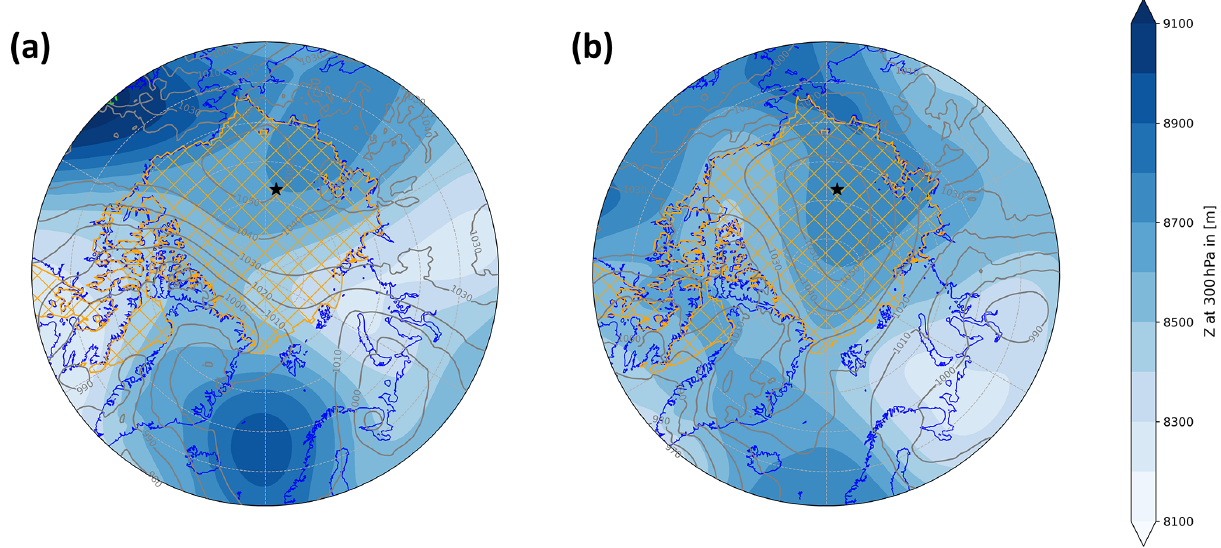
Figure 15. Synoptic situation on (a) 20 January 2013 (day 51) and (b) 24 January 2013 (day 55). Daily-mean geopotential height at 300hPa (in m, color). Sea level pressure (grey contours, in intervals of 10hPa) and blocking mask (dashed green contour) at 00:00UTC on the considered days. Black star at 78.5 ◦ N, 173 ◦ E shows location of skew T –log p profile in Fig. 16. Sub-region ARI is marked by orange